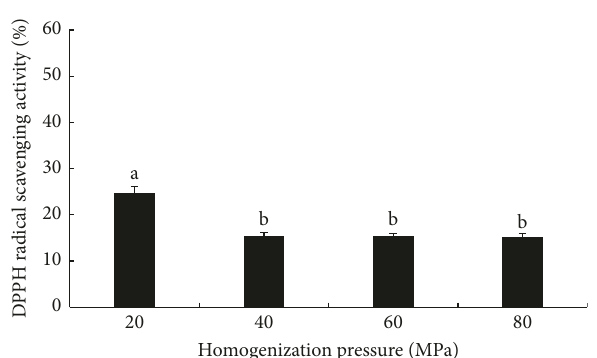
Figure 2: DPPH radical scavenging activity of the emulsions (oil: 5g/100 g; SC: 1g/100g) processed at different pressures. Different letters above bars indicate significant differences among samples ( p < 0 . 05).